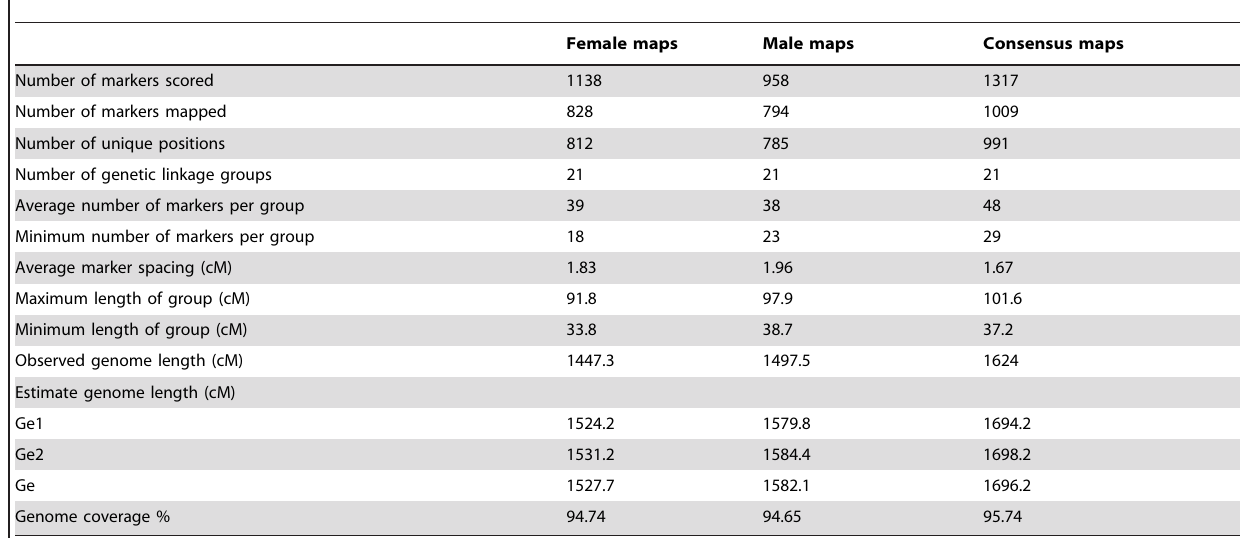
Table 2. Summary of genetic linkage maps of half-smooth tongue sole.